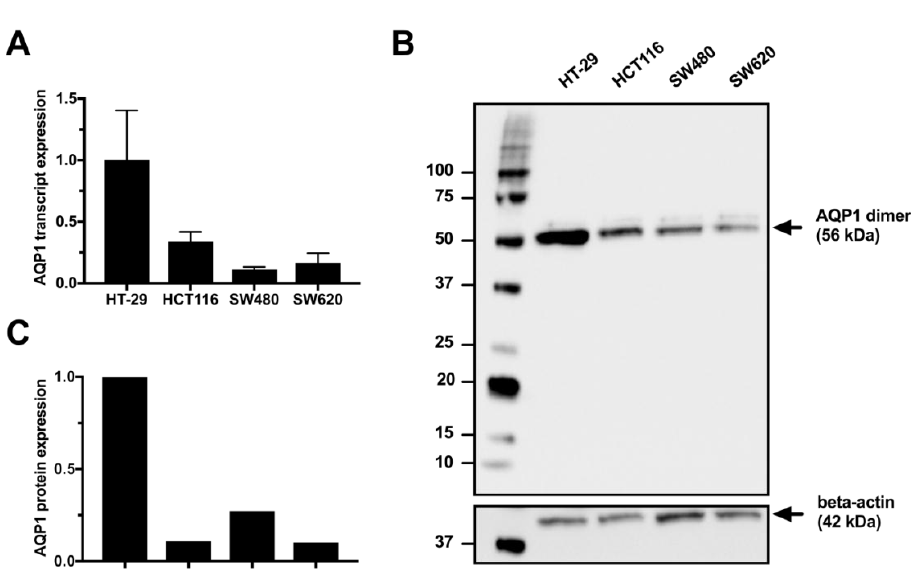
Figure 1. ( A ) Relative AQP1 transcript expression in untreated HT-29, HCT116, SW480, and SW620 colon cancer cell lines. Transcript expression was calculated using the ΔΔCt relative quantification method, normalising to PMM1 reference gene. Results are the mean ± SD of biological triplicates, relative to the expression in HT-29. ( B ) Representative western immunoblot for AQP1 protein expression in untreated HT-29, HCT116, SW480, and SW620 colon cancer cell lines. ( C ) Relative AQP1 protein expression in untreated HT-29, HCT116, SW480, and SW620 colon cancer cell lines. AQP1 expression was normalised to beta-actin loading control and relative to the expression in HT-29.